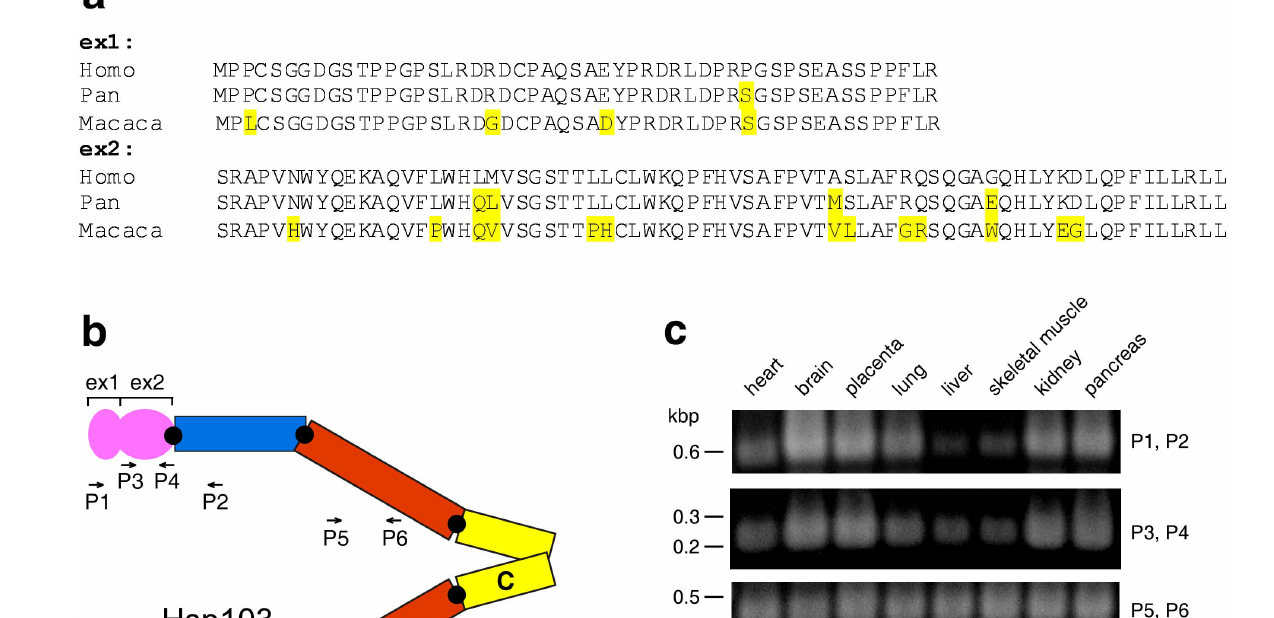
endogenous Hsp103 mRNA expression in HEK293 cells is below 1% compared to Hsp90 a (Fig. 1d, e), suggesting that endogenous Hsp103 mRNA expression is tightly regulated and may play a specific role beyond that of Hsp90 a . Remarkably, Hsp90 b lacks